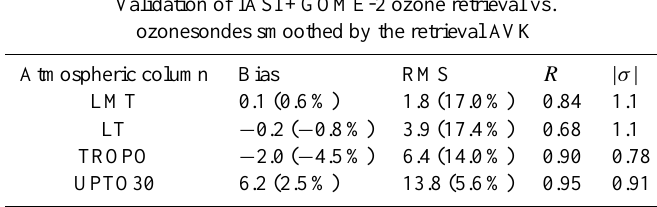
Table 3. Direct comparison of IASI+GOME-2 ozone retrievals against raw ozonesonde measurements. The same as Table 2 but without smoothing ozonesonde profiles with IASI+GOME-2 averaging kernels. We also provide estimations of the total and smoothing retrieval errors, s tot and s smooth , for the IASI+GOME-2 retrievals used in the col col